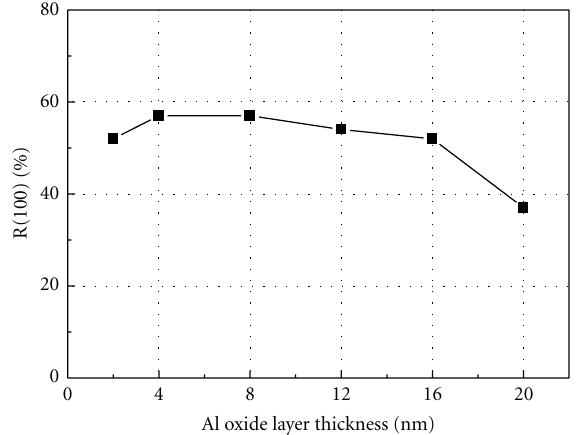
Figure 8: Fraction of preferential (100) orientation, R (100) from EBSD data of the pc-Si films, measured after [7] as a function of Al oxide layer